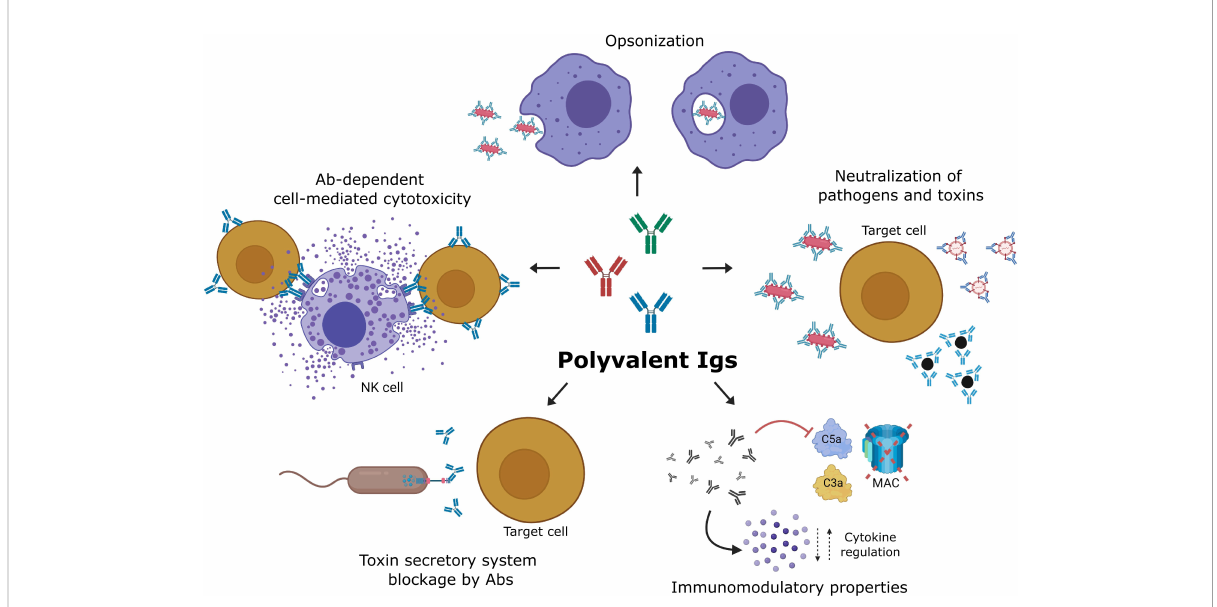
FIGURE 1 Mechanisms of action of IVIG during the treatment of infections. The neutralization of microbes, toxins, and superantigens blocks the interaction with receptors, preventing their internalization and effects. The opsonization of distinct microbes, such as viruses, bacteria, and fungi, facilitates their phagocytosis and intracellular killing. Antibody-dependent cell-mediated cytotoxicity (ADCC) allows NK cells to kill virus-infected cells that express viral antigens on their membranes. Antibodies of IVIG may also recognize and block components of the Type III toxin secretory system of bacteria, inhibiting toxin injection into host cells. Immunoglobulin molecules in IVIG preparations scavenge activated complement fragments and, thereby, prevent indiscriminate lysis of host cells, immune damage mediated by enhanced opsonophagocytosis, and exaggerated in fl ammatory reaction. Created with